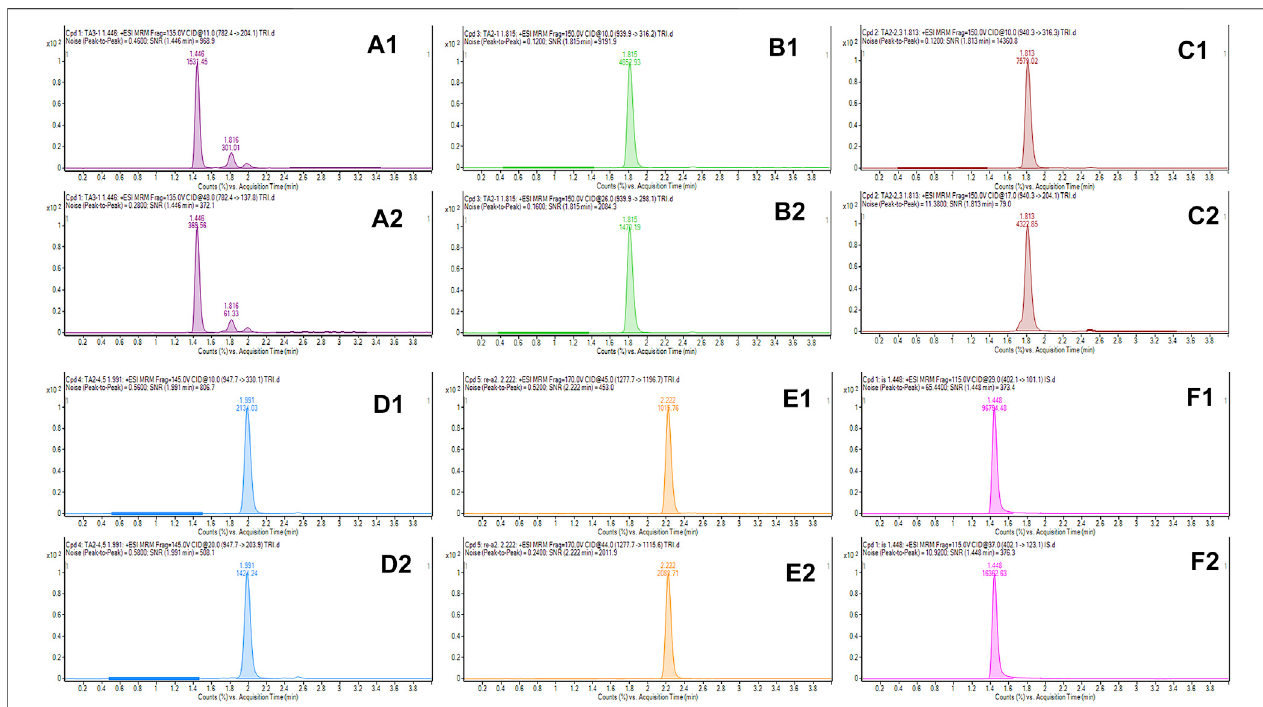
FIGURE1| Representativechromatogramsobtainedfromthecalibratorstandardat100 ngml – 1 forteicoplanin,ramoplanin,andtheinternalstandard. A1 , A2 , B1 , B2 , C1 , C2 , D1 , D2 , E1 , E2 , F1 , and F2 refer to TA3-1 (782.4/204), TA3-1 (782.4/137.8), TA2-1 (939.9/316.2), TA2-1 (939.9/298.1), TA2-2,3 (940.3/316.3), TA2-2,3 (940.3/204.1), TA2-4,5 (947.7/330.1), TA2-4,5 (947.7/203.9), RA2(1277.7/1196.7), RA2 (1277.7/1115.6), IS (402.1/101.1), and IS (402.1/123.1),